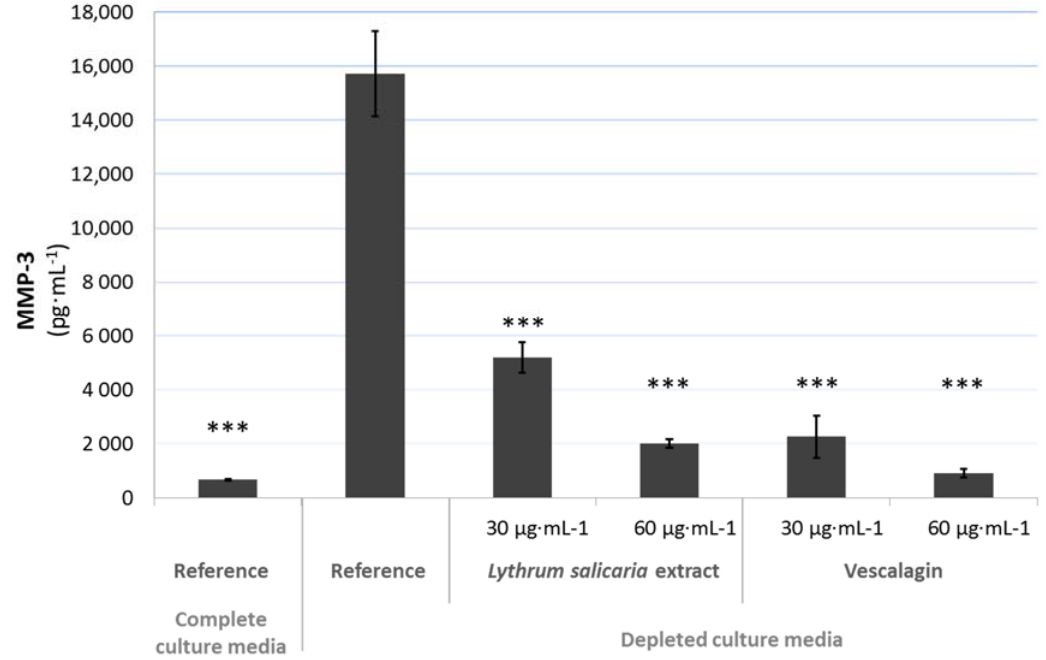
Figure 7. Effect of Lyth. s. extract and vescalagin on expression of MMP-3 in FTSK monitored by ELISA quantification in cell culture subnatants of FTSK (statistical significances; see details in Figure 6).